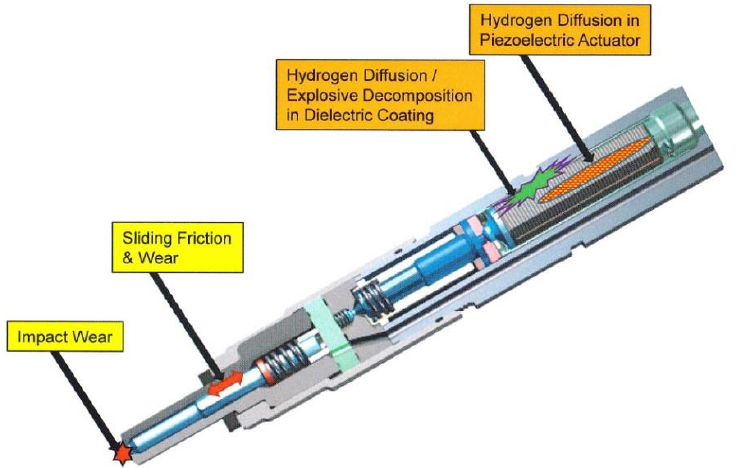
Figure 4. Areas and types of fuel injector damage [109,136].